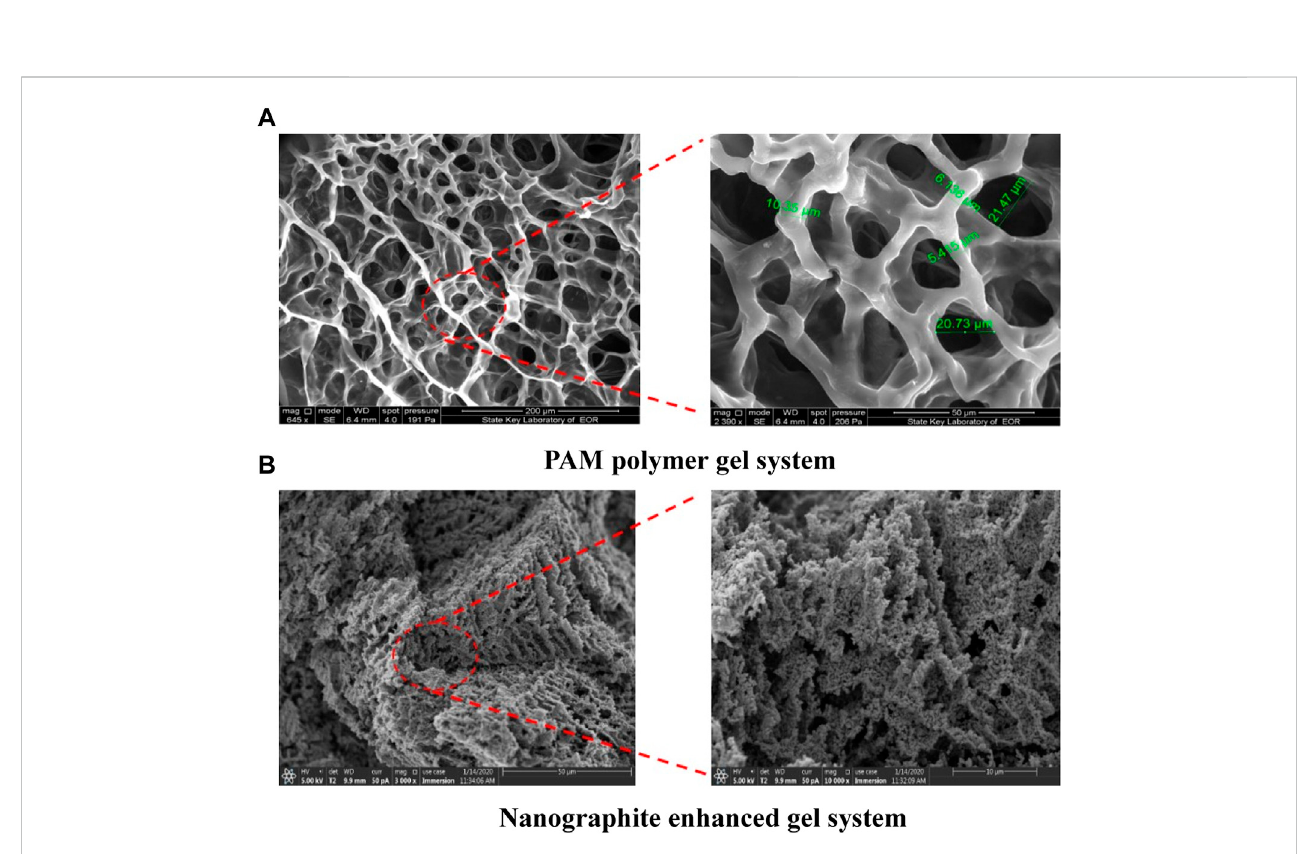
FIGURE 11 SEM images of the (A) PAM gel system and (B) nano-graphite enhanced gel system (Lv et al., 2020).